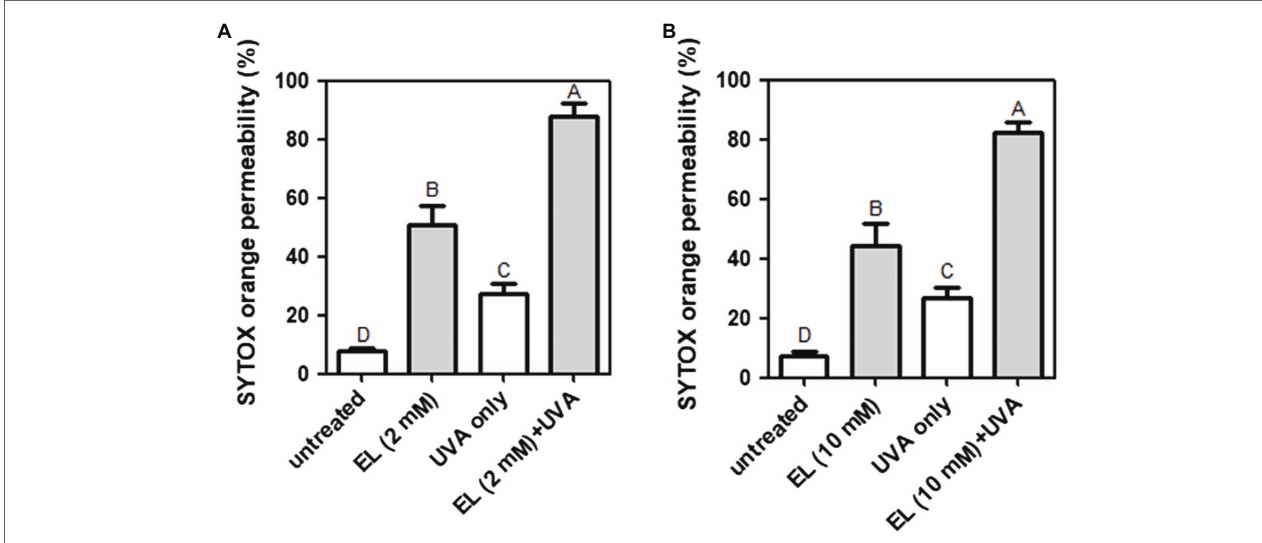
FIGURE 4 | Permeation of SYTOX orange into (A) L. innocua and (B) E. coli O157:H7 cells treated with EL with or without UVA light (30 min). Means of three independent measurements are shown. Different uppercase letters indicate significant differences ( p ≤